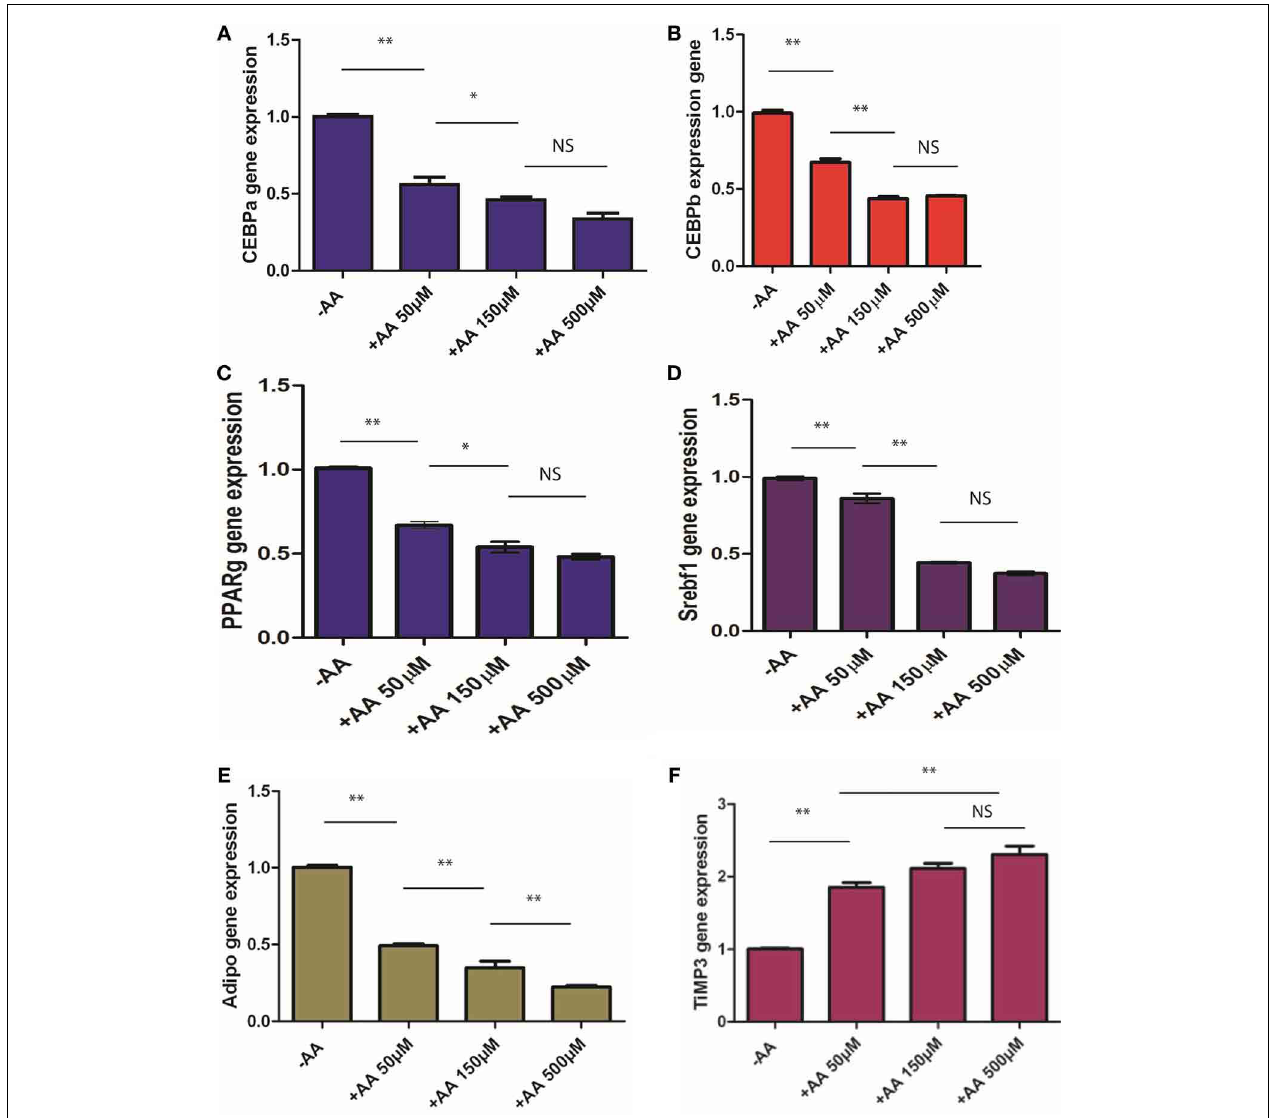
FIGURE 3 | Markers expression. 3T3 L1 were cultured without IBMX and without or with different concentrations of AA. RNAs were extracted after 9 days and expression of different genes, CEBP α (A) , CEBP β (B) , PPAR γ (C) ,